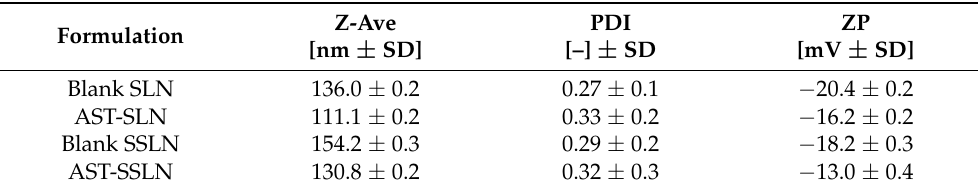
Table 1. Mean particle size (Z-Ave), polydispersity index (PDI), and zeta potential (ZP) of SLN and SSLN unloaded and loaded with AST.